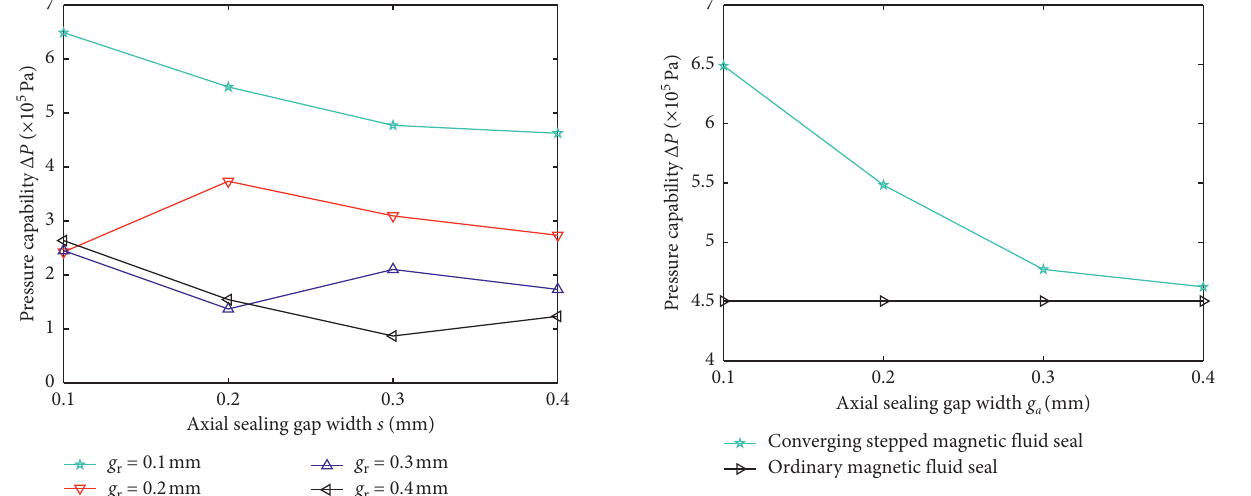
Figure 8: Pressure capability comparison between converging : radial stepped seal and ordinary seal. Figure 7: Effect of sealing positions on sealing capability. g r